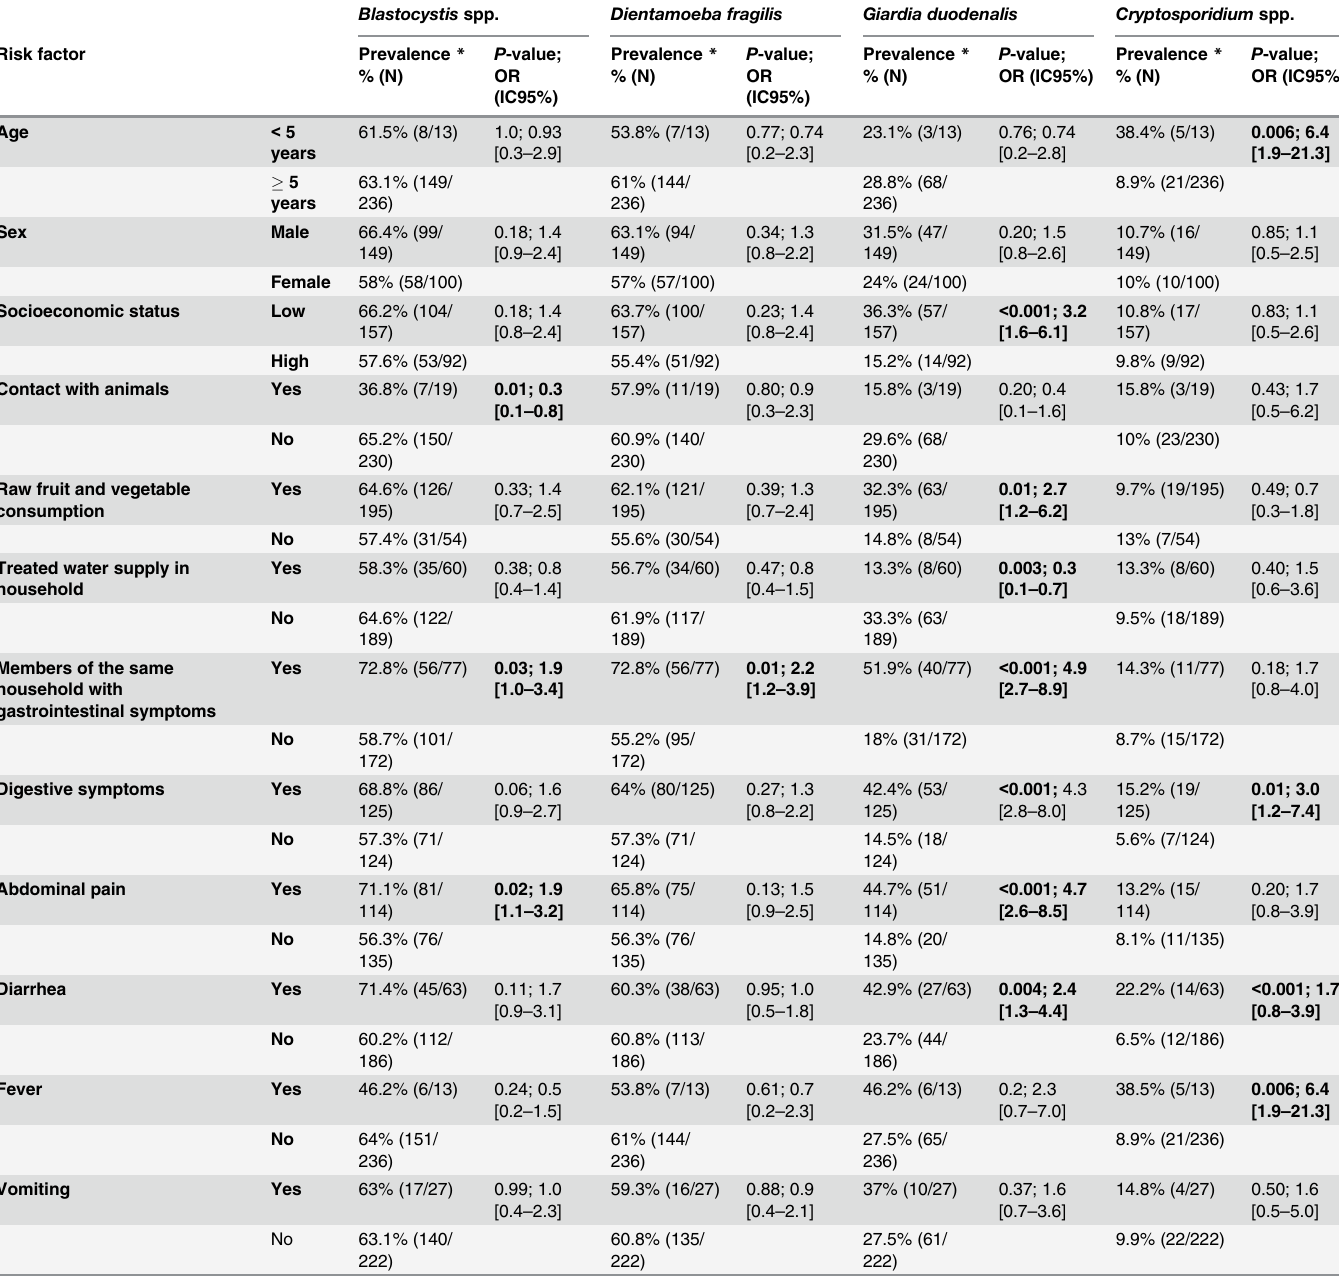
Table 2. Distribution of protozoan infections among schoolchildren in Tripoli according to risk factors. Blastocystis spp. Dientamoeba fragilis Giardia